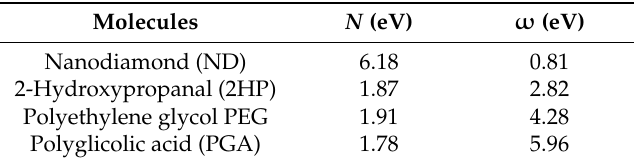
Table 1. Nucleophilicity N and electrophilicity ω indexes of esterification reaction.